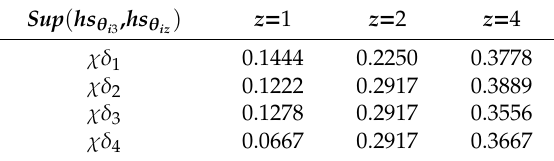
Table 4. Support degree of hs θ